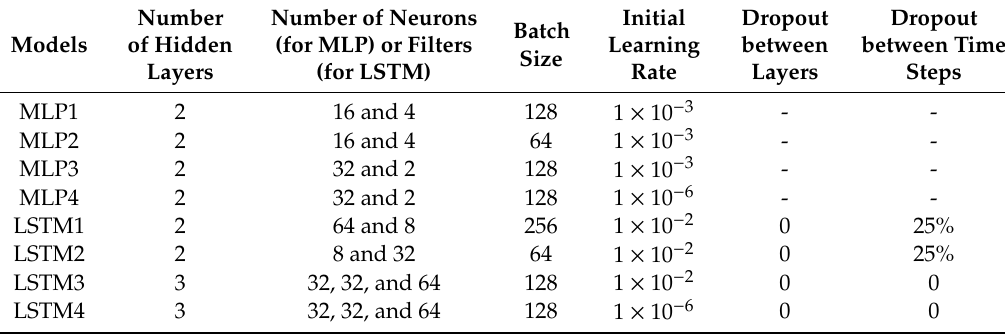
Table A2. Hyper-parameters of the proposed MLP and LSTM